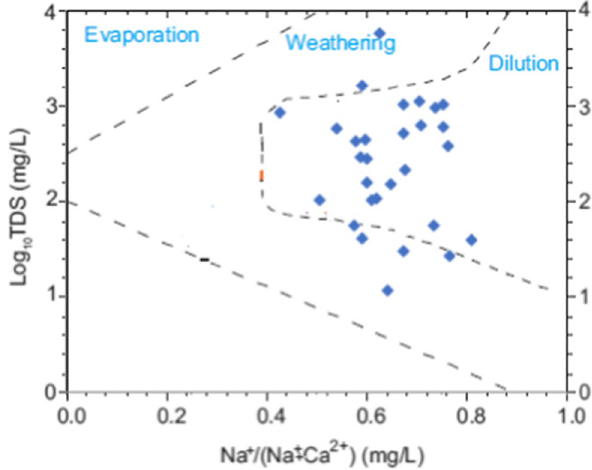
Fig. 2 Gibb’s diagrams of groundwater samples from the study